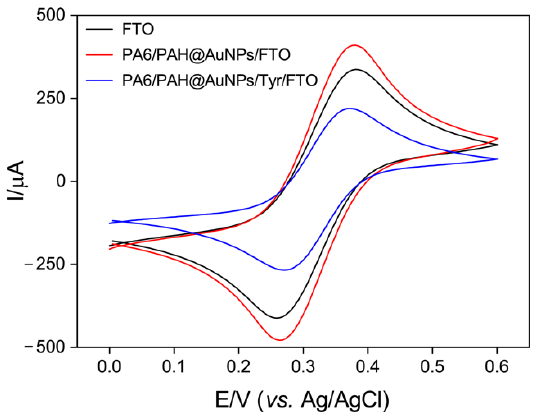
Figure 2. CV curves of FTO, PA6/PAH@AuNPs/FTO, and PA6/PAH@AuNPs/Tyr/FTO using a 0.05 M [Fe(CN) 6 ] 3−/4− solution containing 0.1 M KCl.